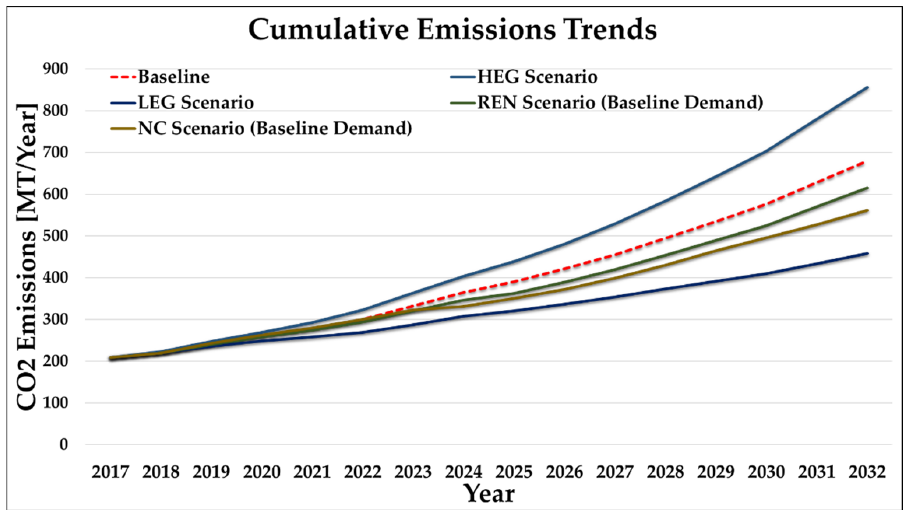
Figure 15. Cumulative emissions trends under different scenarios.